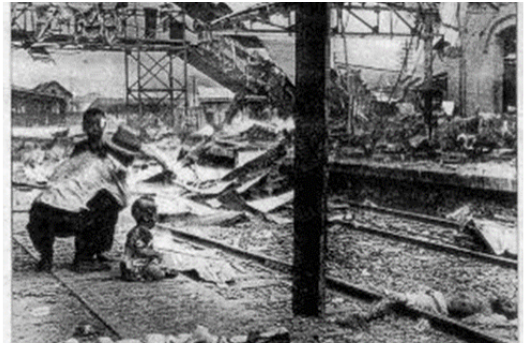
Figure 5. Rescue of baby Ping-Mei. Source: LOOK